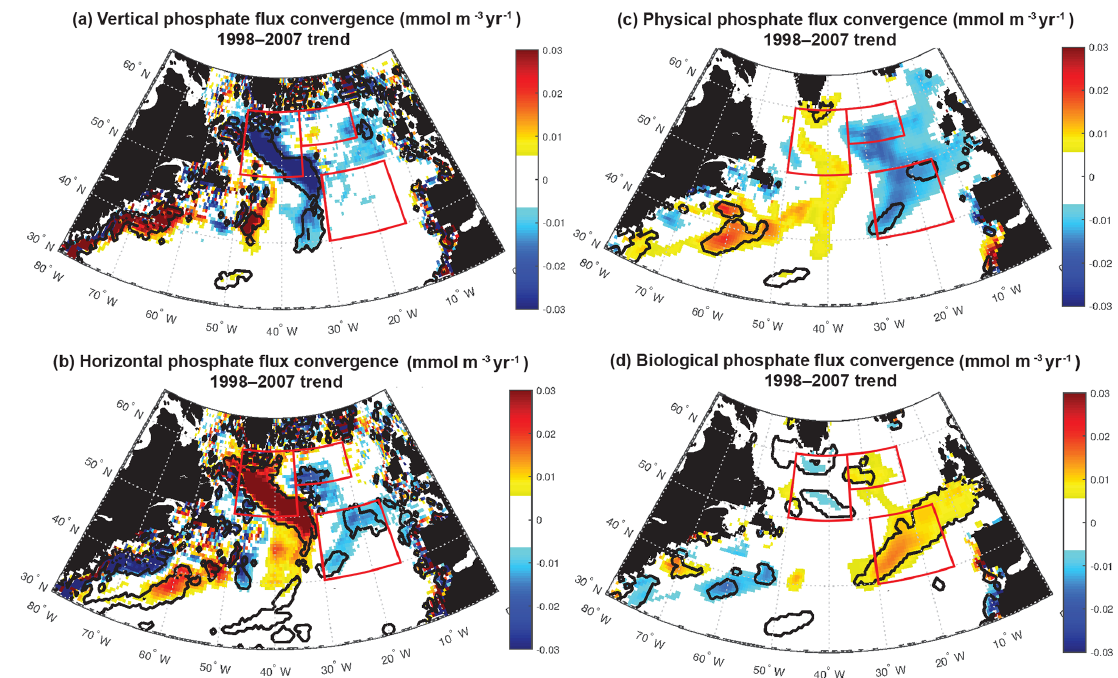
Figure 10. Phosphate diagnostics 1998–2007 trends: 0–100m flux convergence trend (mmolm − 3 yr − 2 ) for (a) vertical, (b) horizontal, (c) net physical, and (d) biological flux convergences. Positive biological trends are consistent with negative biomass trends because less phosphate is removed as less biomass is formed. Significant trends are marked with a black contour and the three focus regions are outlined in red in each